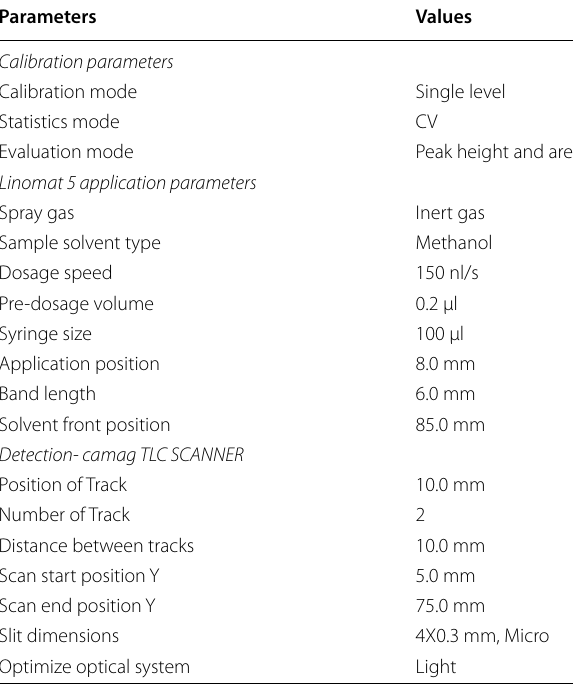
Table 1 Parameters for fingerprinting